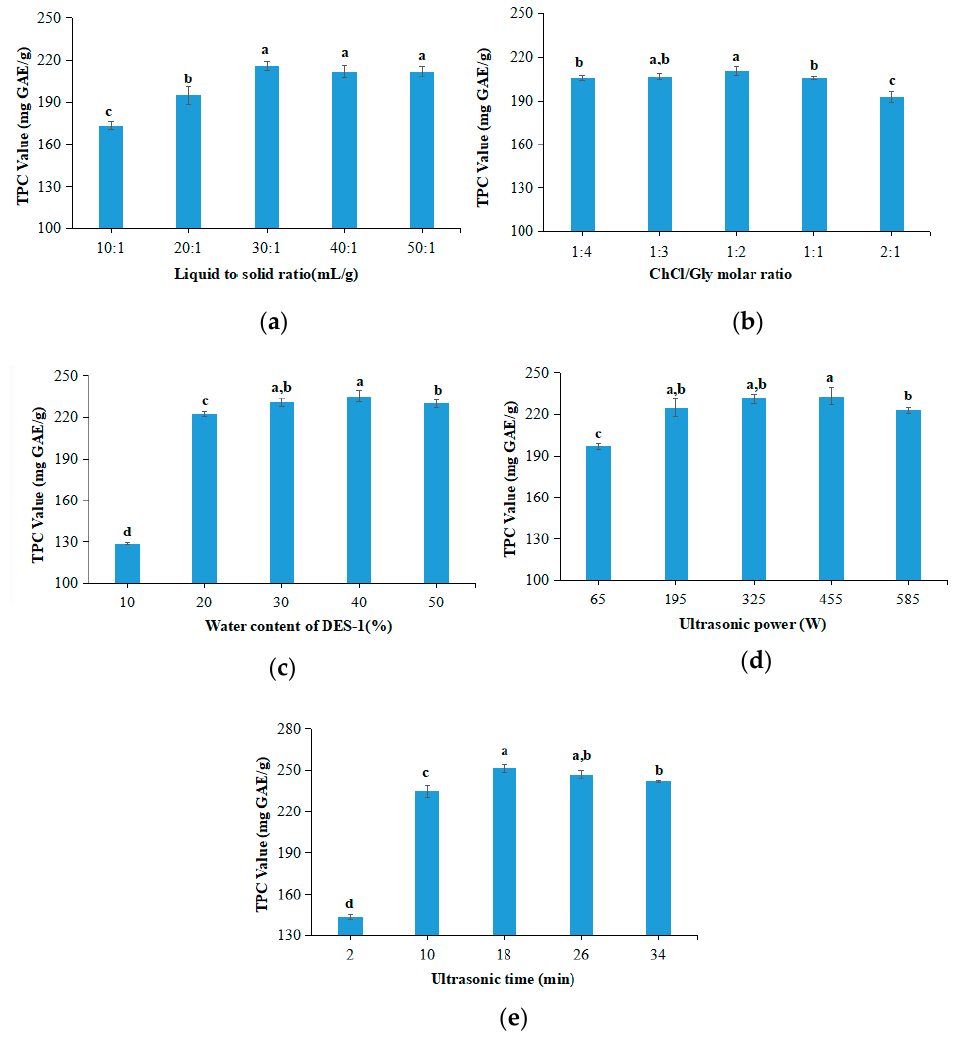
Figure 2. Results of the single-factor experiments. ( a ) Liquid to solid ratio; ( b ) ChCl/glycerol molar ratio; ( c ) water content in ChCl-glycerol; ( d ) ultrasonic power; ( e ) ultrasonic time. Data (a–d) are expressed as means ± SD of n = 3 samples.